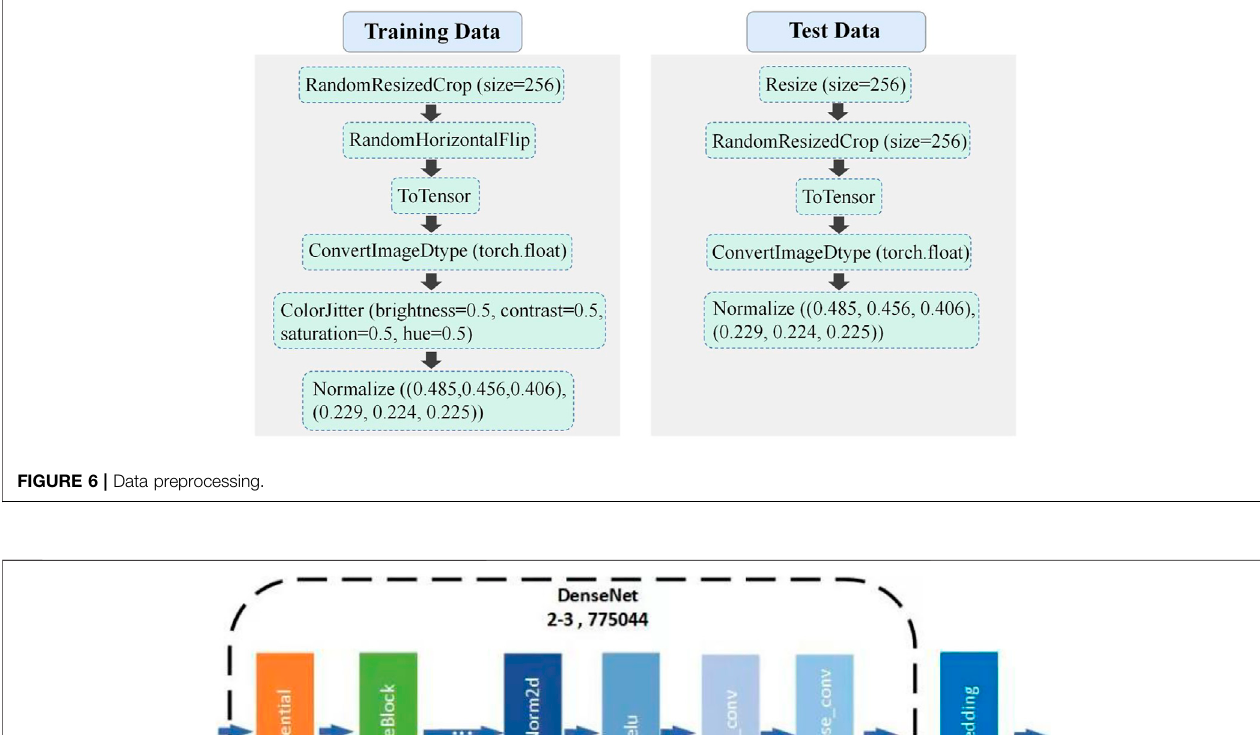
FIGURE 7 | CNN module